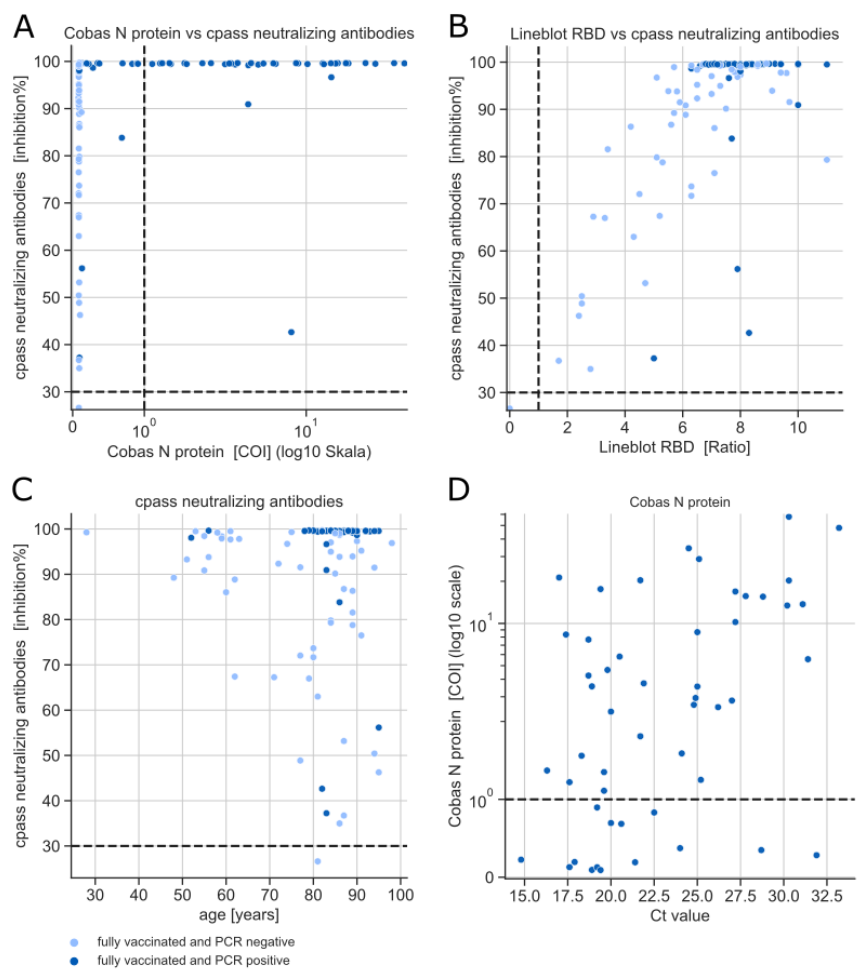
Figure 3. ( A ) Correlation of neutralizing antibodies with α -N antibodies (exemplified by Cobas N protein), Spearman Rank correlation coefficient r = 0.648 ( p < 0.001) (all samples), r = − 0.025 ( p = 0.859) (PCR Negatives) and r = 0.277 ( p = 0.045) (PCR Positives), ( B ) correlation of neutralizing antibodies with α -RBD antibodies (exemplified by Mikrogen Lineblot), Spearman Rank correlation coefficient r = 0.587 ( p < 0.001) (all samples), r = 0.713 ( p < 0.001) (PCR Negatives) and r = 0.194 ( p = 0.165) (PCR Positives), ( C ) correlation of neutralizing antibodies with age. Spearman rank correlation coefficient r = 0.062 ( p = 0.531) (all samples), r = − 0.321 ( p = 0.019) (PCR Negatives) and r = − 0.141 ( p = 0.323) (PCR Positives). ( D ) correlation of α -N antibodies (exemplified by Cobas N protein) with Ct values, Spearman Rank correlation coefficient r = 0.417 ( p = 0.002) (PCR Positives